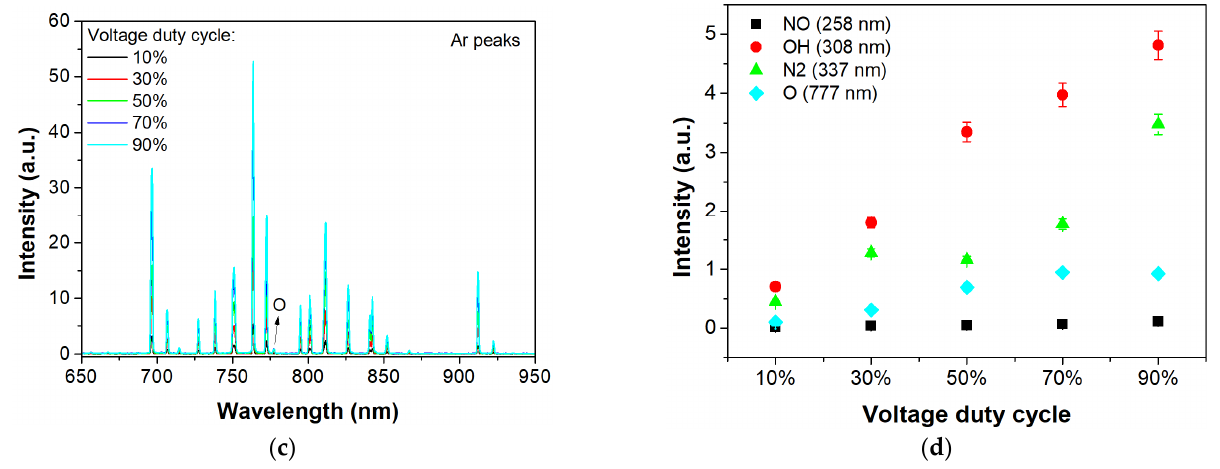
Figure 4. Optical emission spectra of the discharge generated by the funnel reactor for different voltage duty cycles. ( a ) Spectra for the wavelength range from 200 to 450 nm (mainly UV region) and ( b ) detailed spectra highlighting the emission bands of NO and OH from 225 nm to 325 nm. The visible region of the spectra is shown in ( c ) from 650 nm to 950 nm. ( d ) Overview of the OES peaks for different values of voltage duty cycle.